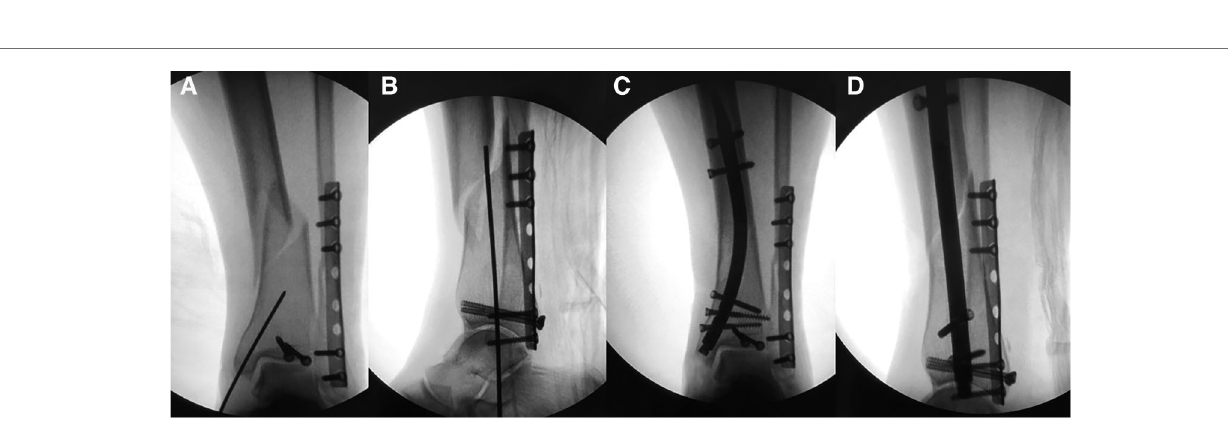
FIGURE 1 | Typical case: female, 54age, fall injury, OTA fracture staging type 42-C1. ( A ) Preoperative X-ray orthopantomograph of distal tibial fracture; ( B ) Preoperative X-ray lateral radiograph of distal tibial fracture; ( C,D ) 3D CT of ankle showing posterior